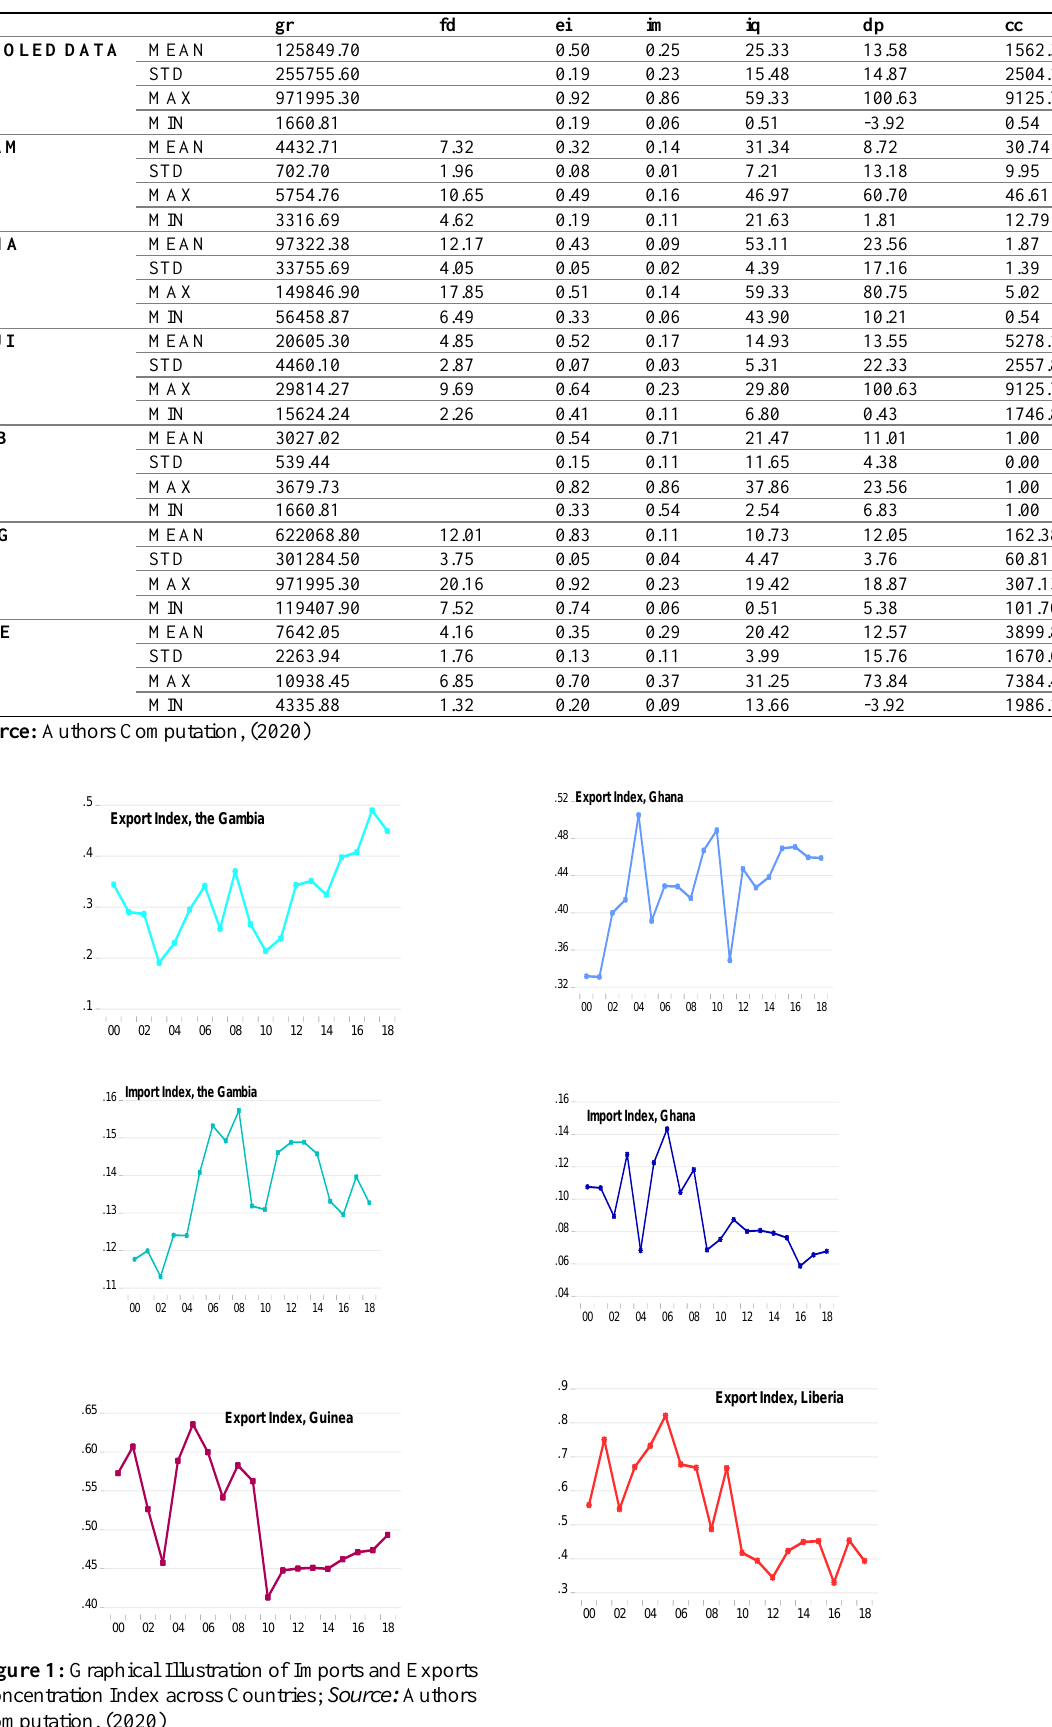
Table 1: Statistical Structure of Data for the Six Countries